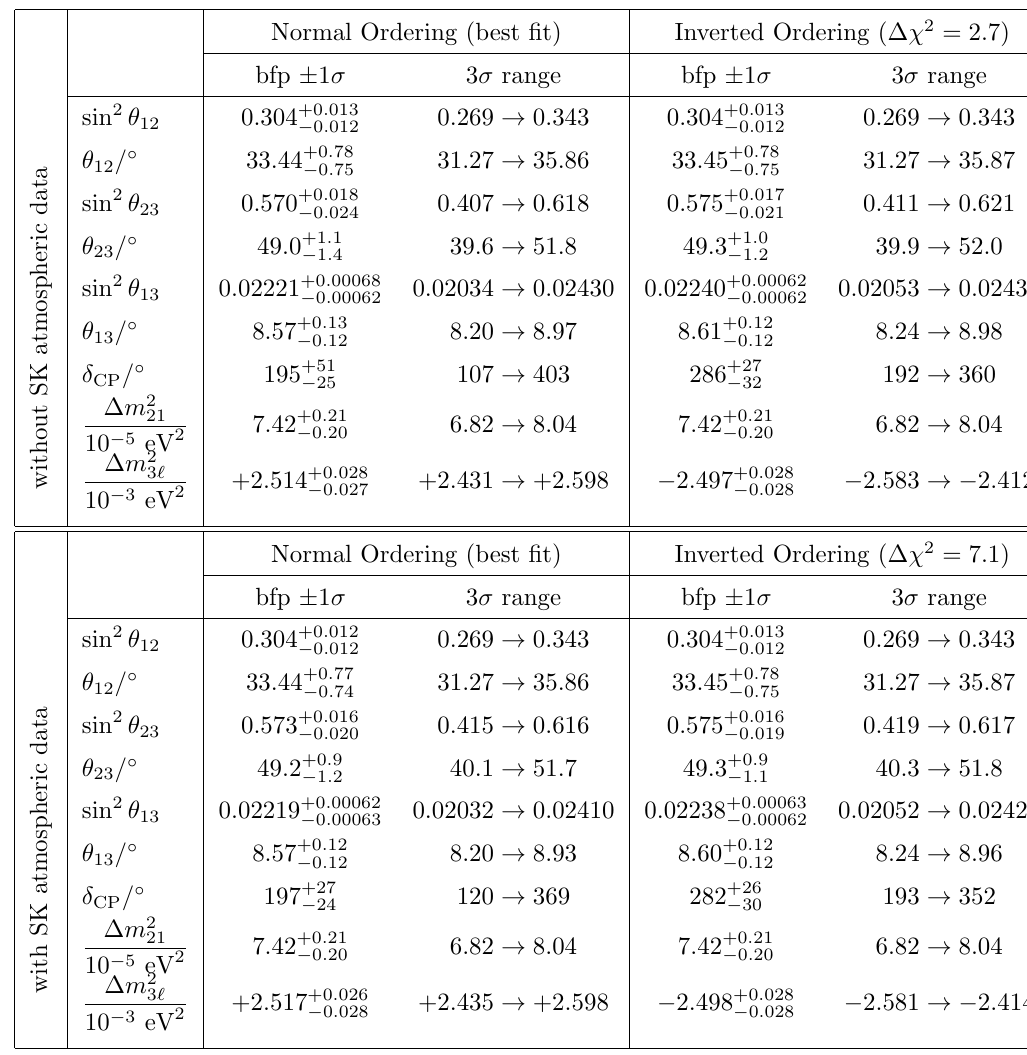
Table 3 . Three-(cid:13)avor oscillation parameters from our (cid:12)t to global data. The numbers in the 1st (2nd) column are obtained assuming NO (IO), i.e., relative to the respective local minimum. Note that (cid:1) m 2 (cid:17) (cid:1) m 2 > 0 for NO and (cid:1) m 2 (cid:17) (cid:1) m 2 < 0 for IO. The results shown in the upper 31 32 3 ‘ 3 ‘ (lower) table are without (with) adding the tabulated SK-atm (cid:1) (cid:31) 2 . Note that there are strong correlations between these allowed ranges due to the